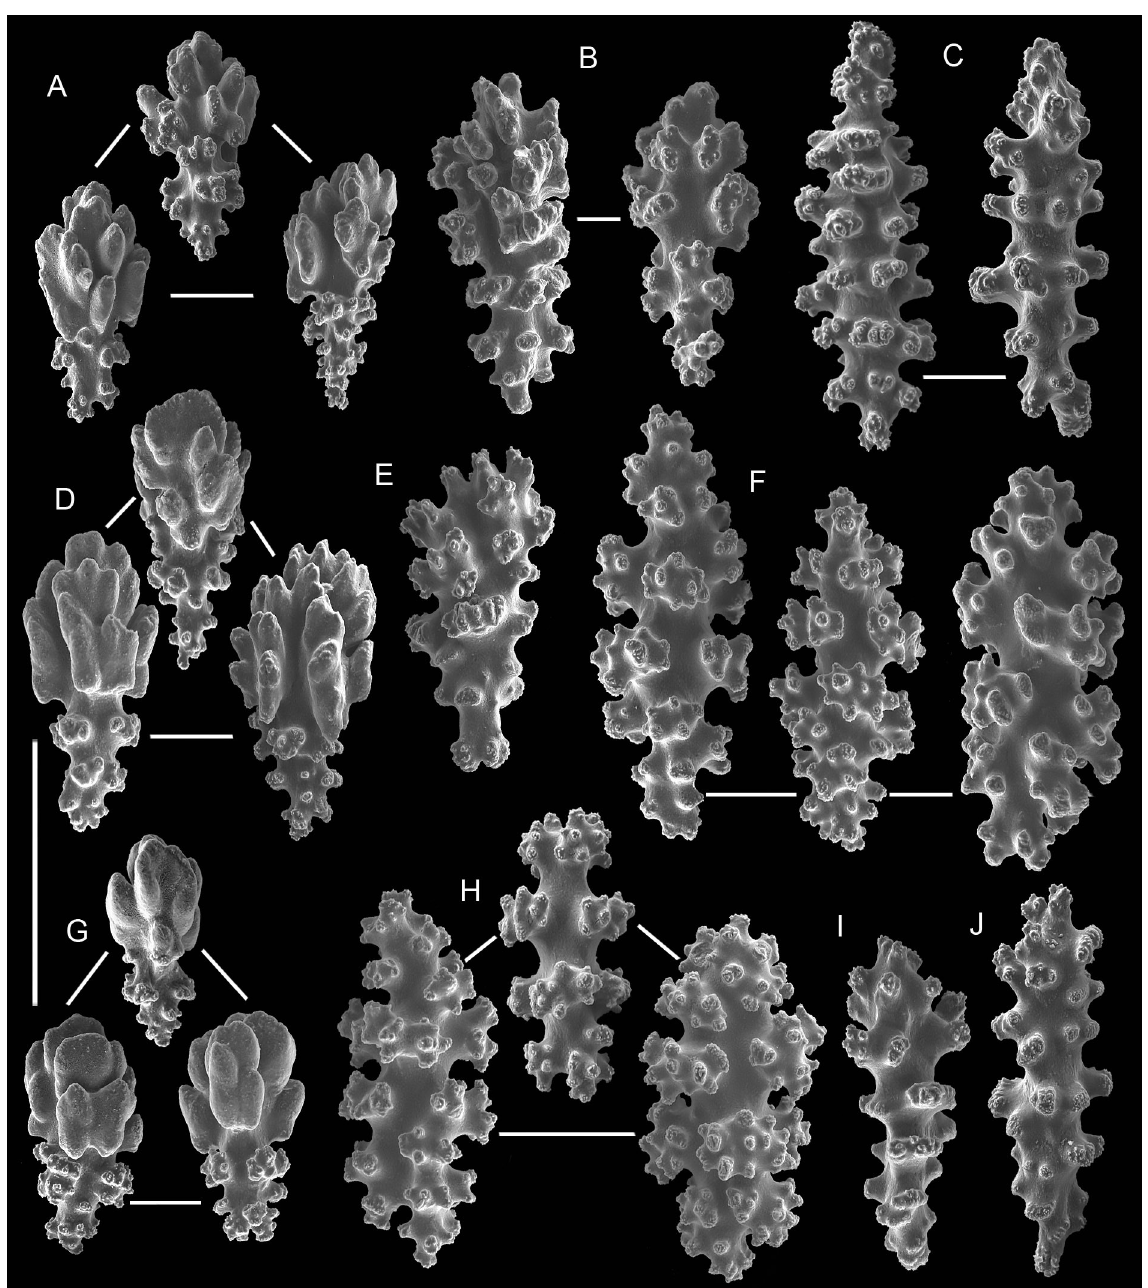
Fig. 5. Calcigorgia matua sp. nov., paratype (MIMB 20724), sclerites. A . Leafy clubs of the tentacles. B . Warty clubs from the tentacles. C . Spindles from the tentacles. D . Leafy clubs from the polyp body wall. E . Warty club from polyp body wall. F . Capstans and 8-radiate bodies of the polyp body wall. G . Leafy clubs from the coenenchyme. H . Capstans and 8-radiate bodies from the coenenchyme. I . Warty club from the coenenchyme. J . Spindle from coenenchyme. Scale bar: 0.1